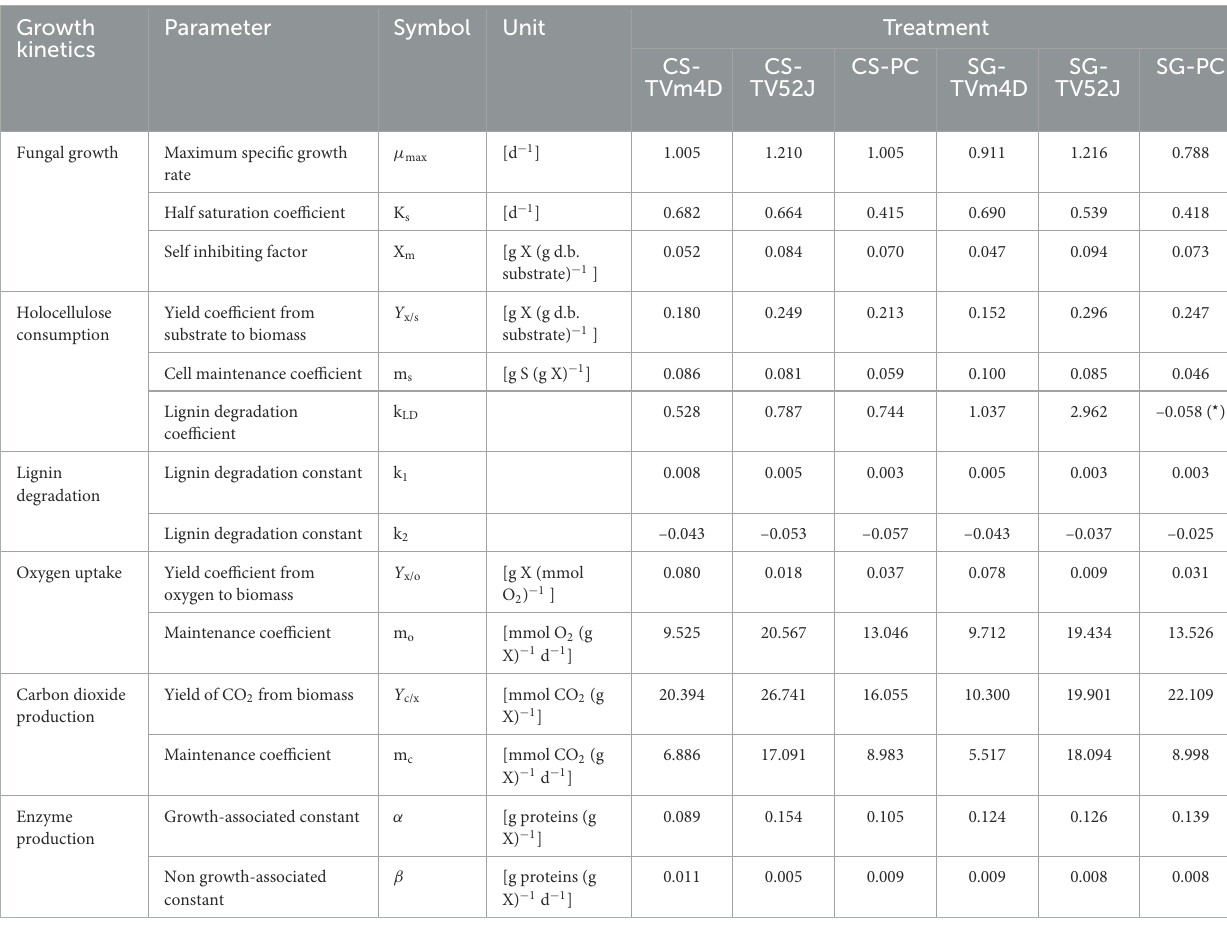
TABLE 1 Estimated parameters of fungal growth, substrate consumption, oxygen uptake, carbon dioxide release, and enzyme production models. Growth